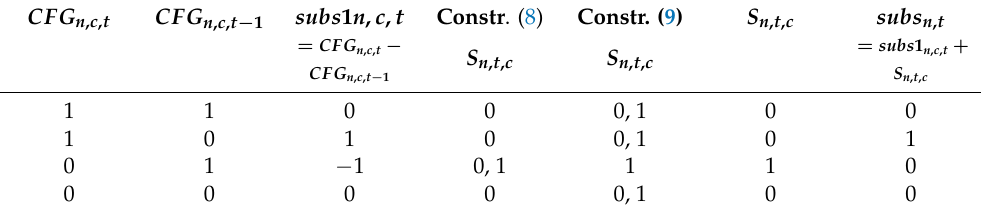
Table 2. Aircraft substitution overview with supporting logic.